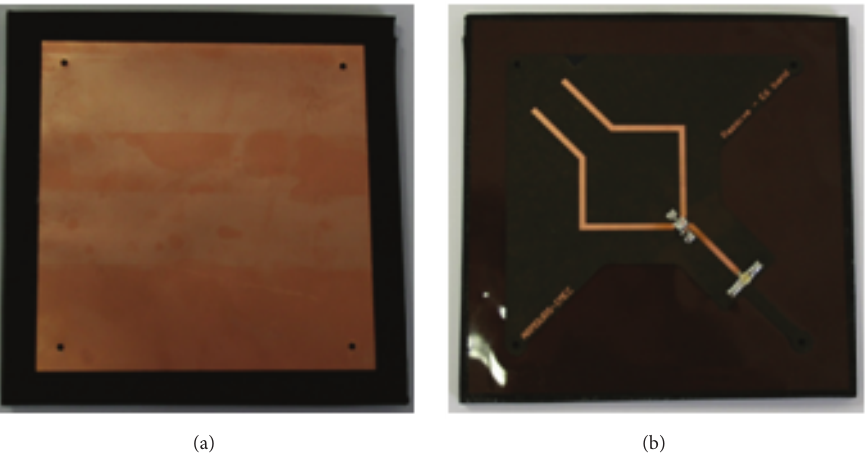
Figure 5: Back (a) and front (b) of the manufactured Galileo E6-band antenna.